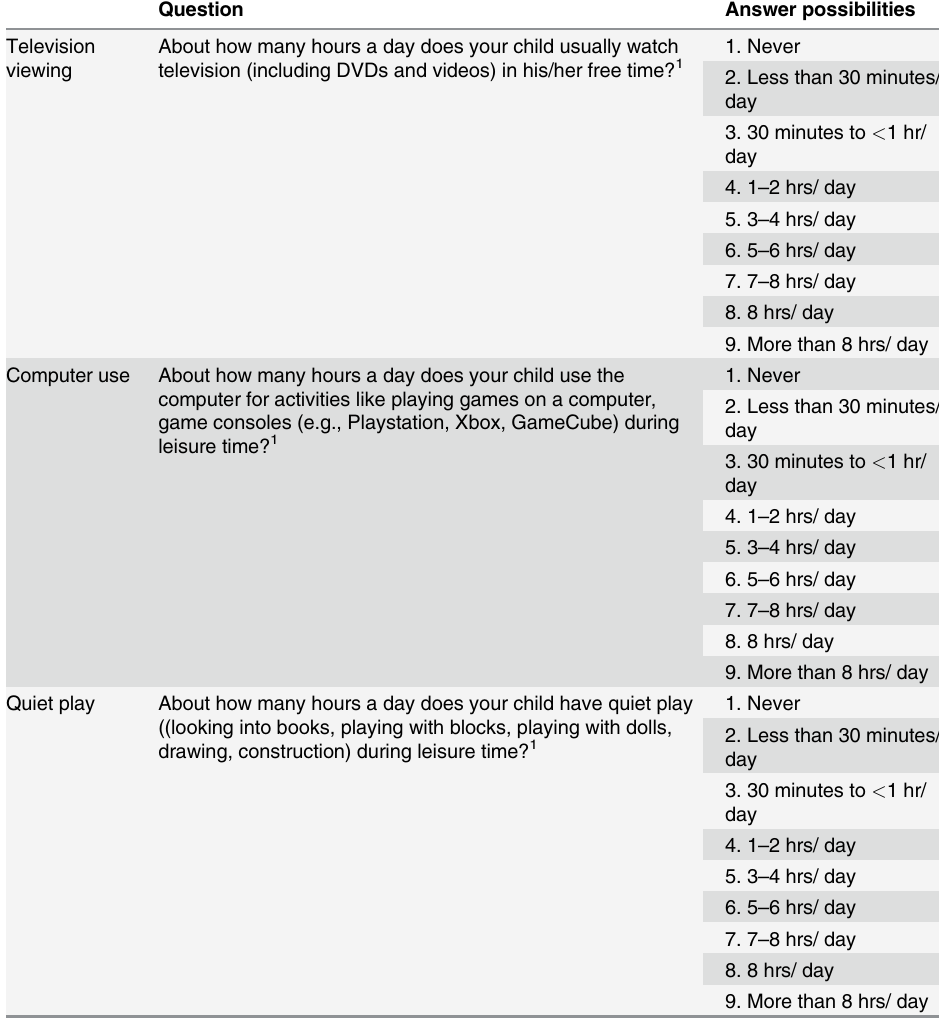
Table 1. Questions and answer possibilities on preschoolers ’ sedentary